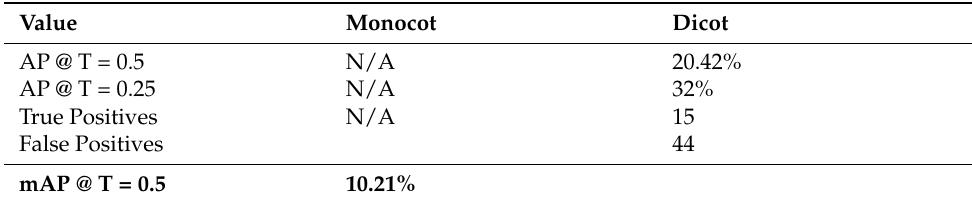
Table 5. Network training results for Training Image Set 3.